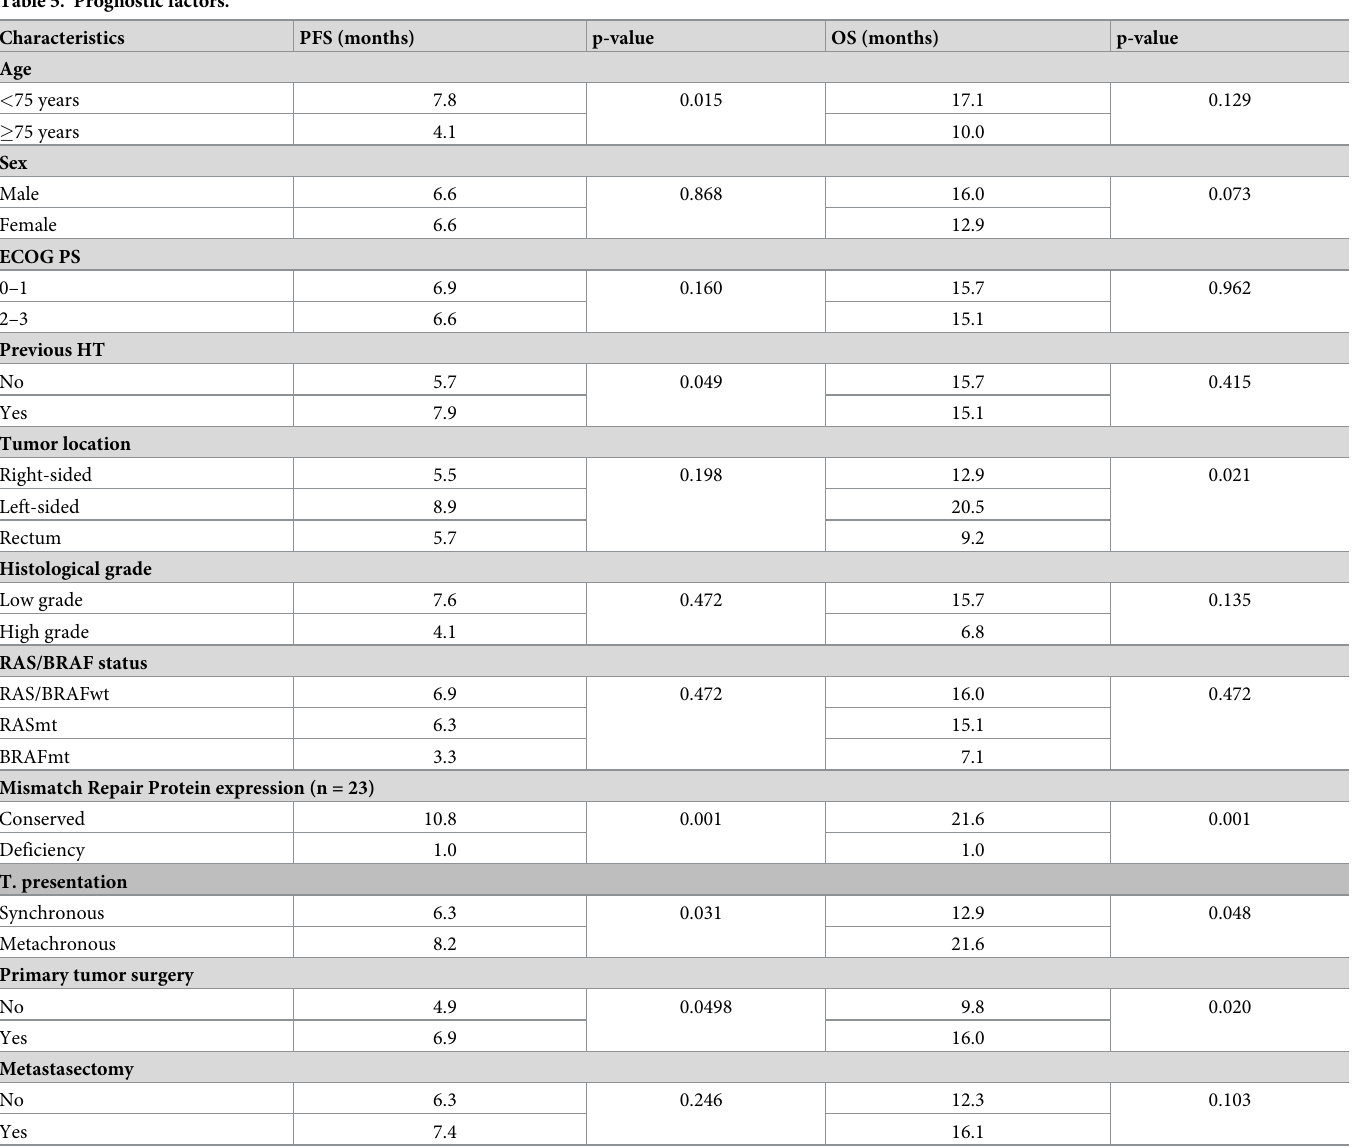
Table 5. Prognostic